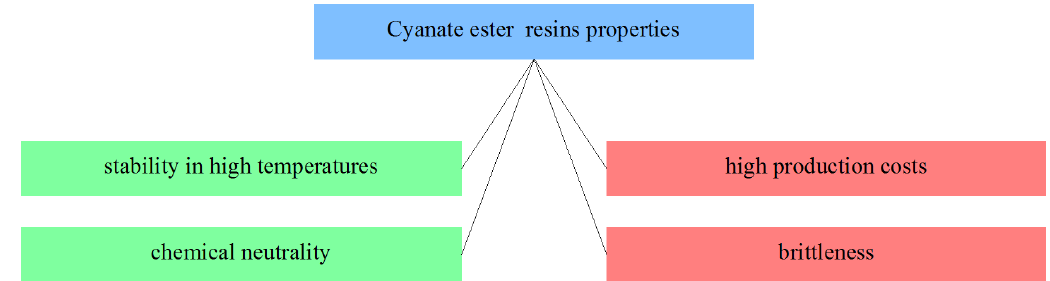
Figure 7: Selected cyanate ester resins properties from the point of view of applicability in friction